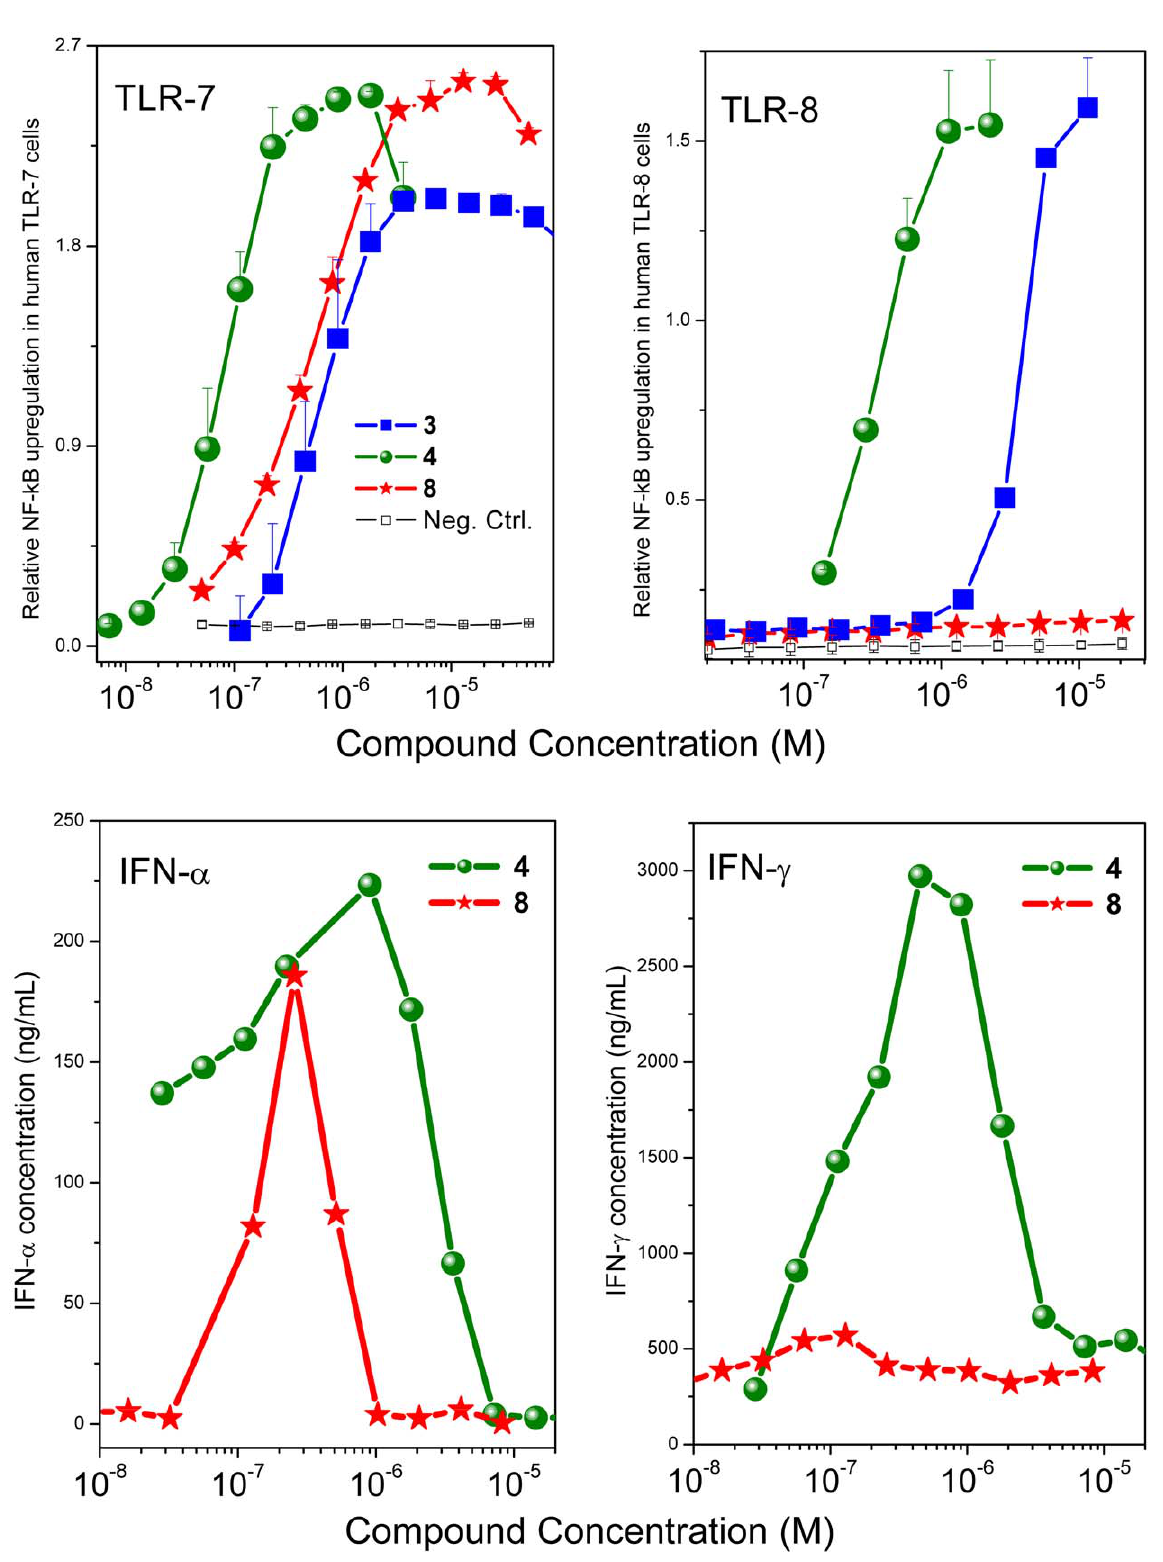
Figure 3. TLR7- and TLR8-agonism and IFN- a and IFN- c induction by Compounds 3, 4, and 8. Top: TLR7- and TLR8-agonistic activity. Reporter gene assays specific for human TLR7 and TLR8 were used. Data points represent means and SD of quadruplicates. Bottom: IFN- a and IFN- c induction by Compounds 4 and 8 in human PBMCs, assayed by analyte-specific ELISAs. Data points represent means of duplicates of three representative experiments.